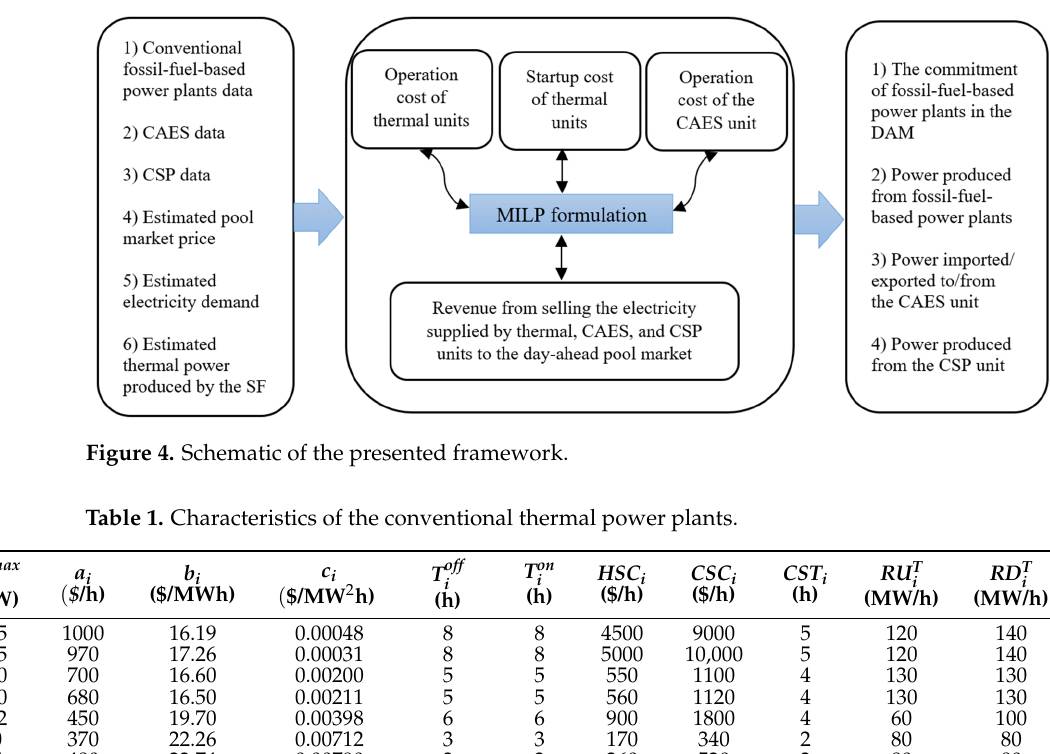
Table 1. Characteristics of the conventional thermal power plants.